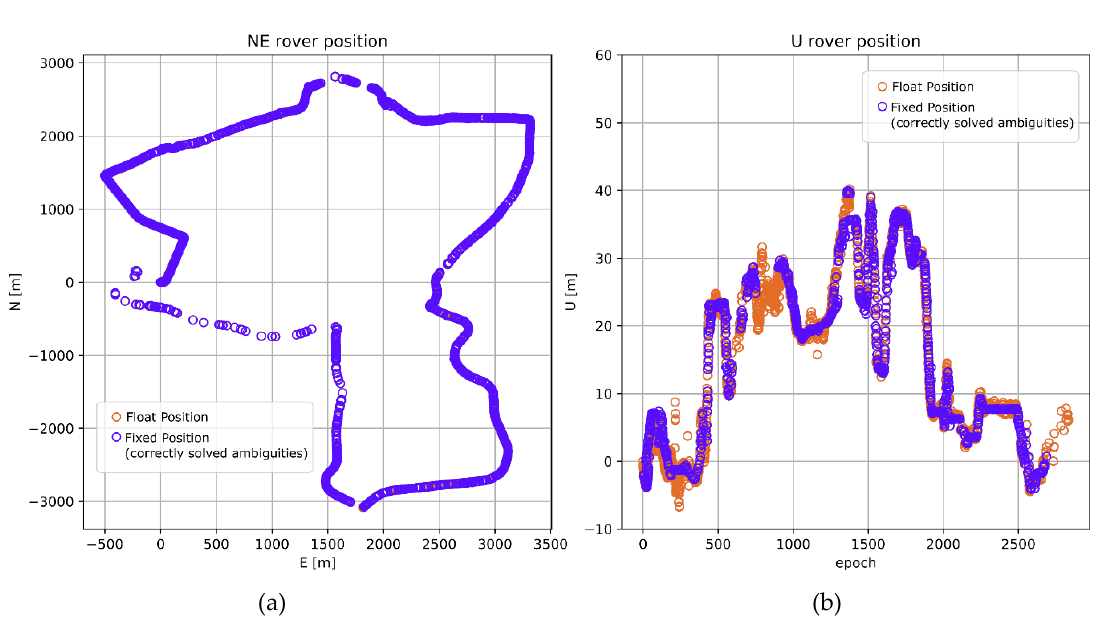
Figure 4. Reference rover trajectory derived from processing short baseline (KRO1). ( a ) Horizontal components; ( b ) Vertical components.